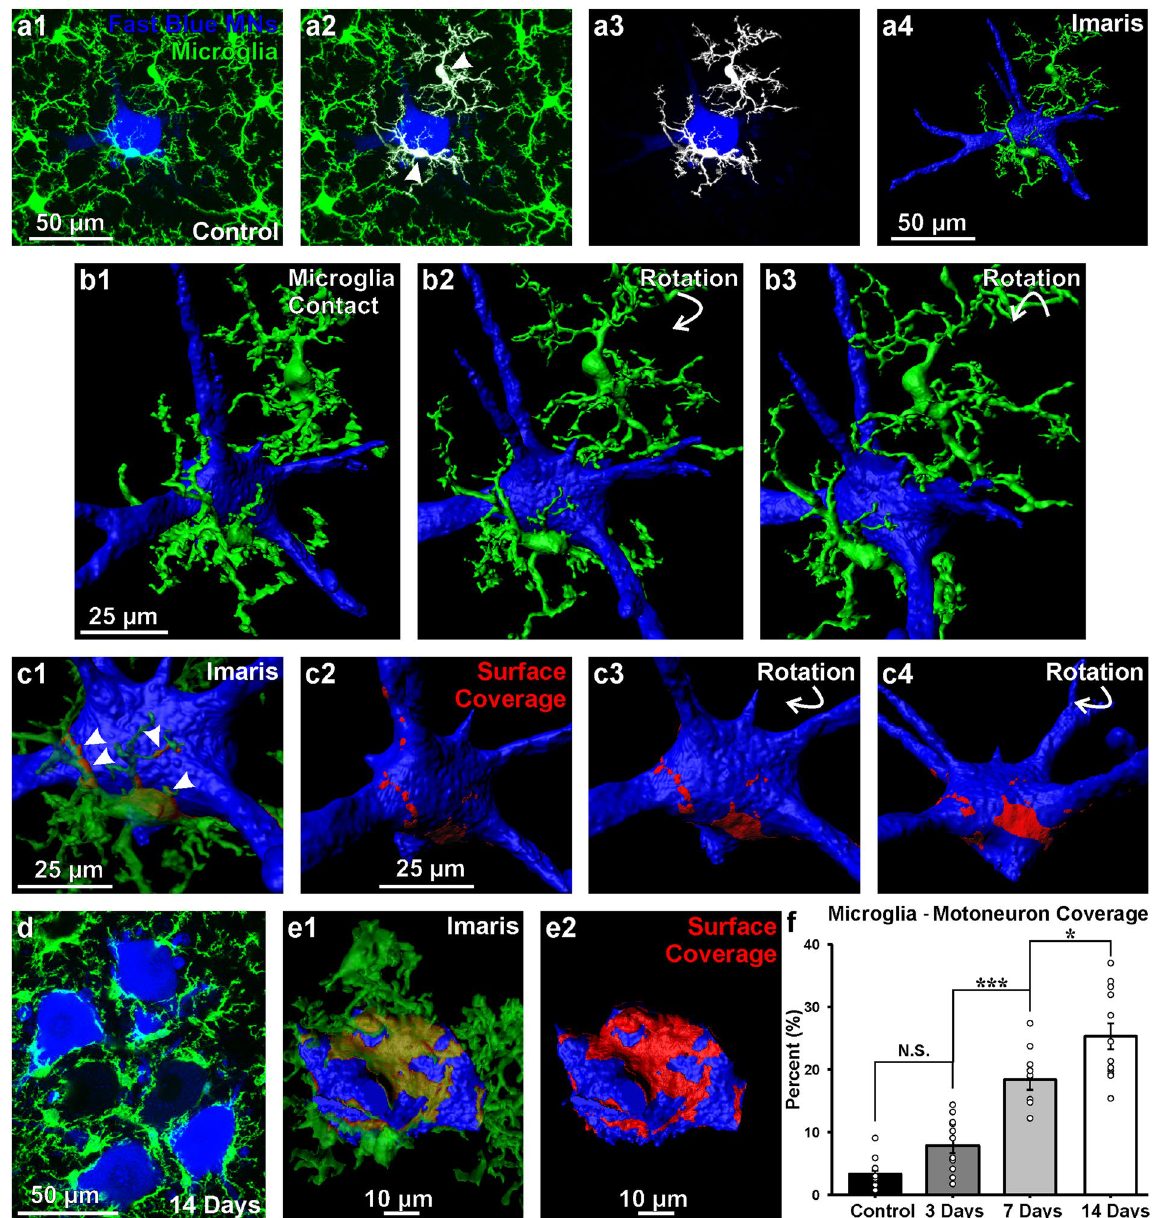
Figure 6. Motoneuron surface is increasingly covered by microglia with time after axotomy. ( a1–4 ) Confocal images and Imaris image segmentation of connected cells. ( a1) 2D projection of a Fast-Blue retrogradely labeled motoneuron and surrounding CX3CR1-GFP microglia in a sham control animal. ( a2,3) Imaris image segmentation of microglia in contact with the Fast Blue labeled motoneuron cell body (white cells in a2) followed by their isolation (a3). ( a4) Surface rendering of the motoneuron and associated microglia. ( b1–3 ) High magnification of reconstructed cells shown at various rotations. ( c1–4 ) Isolation of points of contact. The area detected with distance “0” between motoneuron and microglia surfaces were identified (arrowheads) and rendered (red in c2 ). The motoneuron surface covered by microglia processes is shown in two further rotations (red in c3,c4 ). ( d ) 2D projection of Fast-Blue labeled axotomized motoneurons covered by activated microglia 14 days after the injury. ( e1 ) Surface rendering of one motoneuron cell body and all the attached microglia. ( e2 ) Motoneuron surface covered by microglia processes (red). ( f ) Quantification of the percentage of motoneuron surface covered by microglia. Each dot represents an individual reconstructed motoneuron (n = 10–12 MNs per condition). N.S. non statistical significant trend towards increase surface coverage from sham controls to 3 days post-injury. *** p < 0.001 and ** p < 0.01 statistical significant increases in surface coverage from 3 to 7 days after injury and 7 to 14 days after injury. Supplementary movies 9 and 10 show respectively microglia surface coverage of control and axotomized